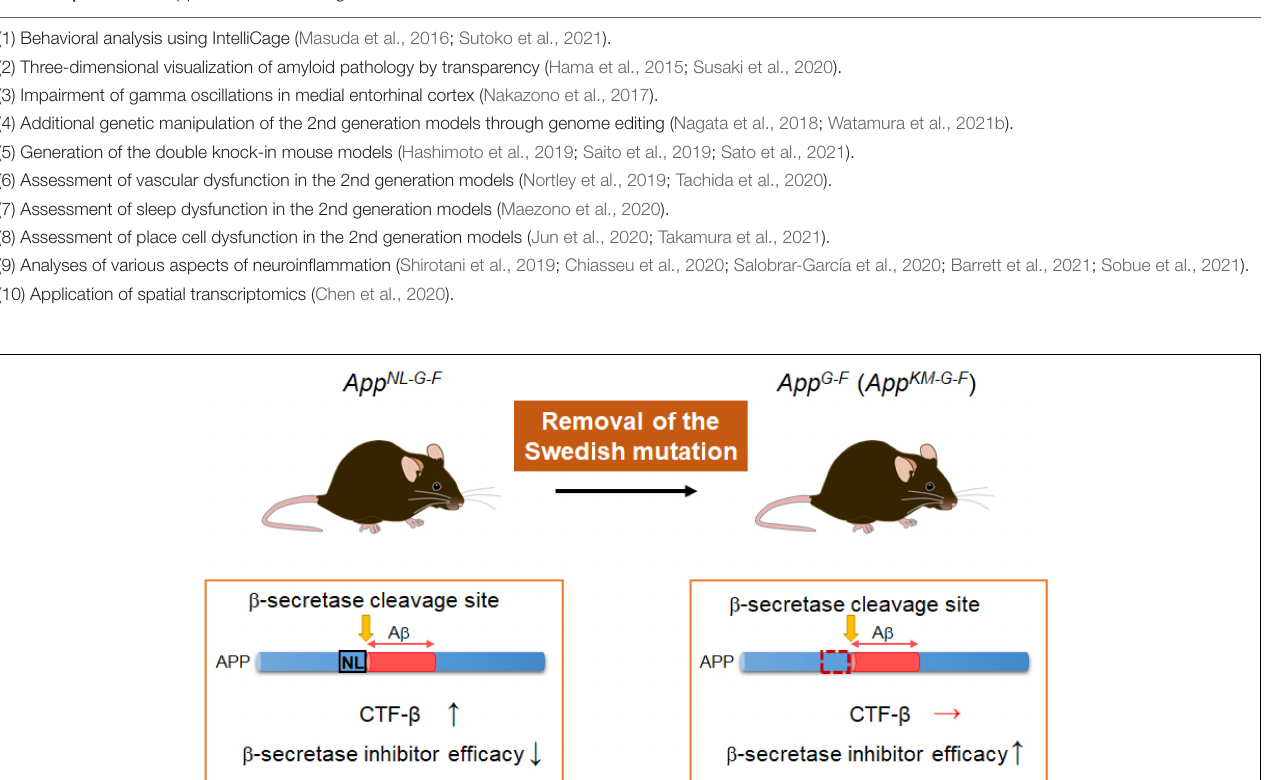
TABLE 1 | Successful application of the 2nd generation mouse models.